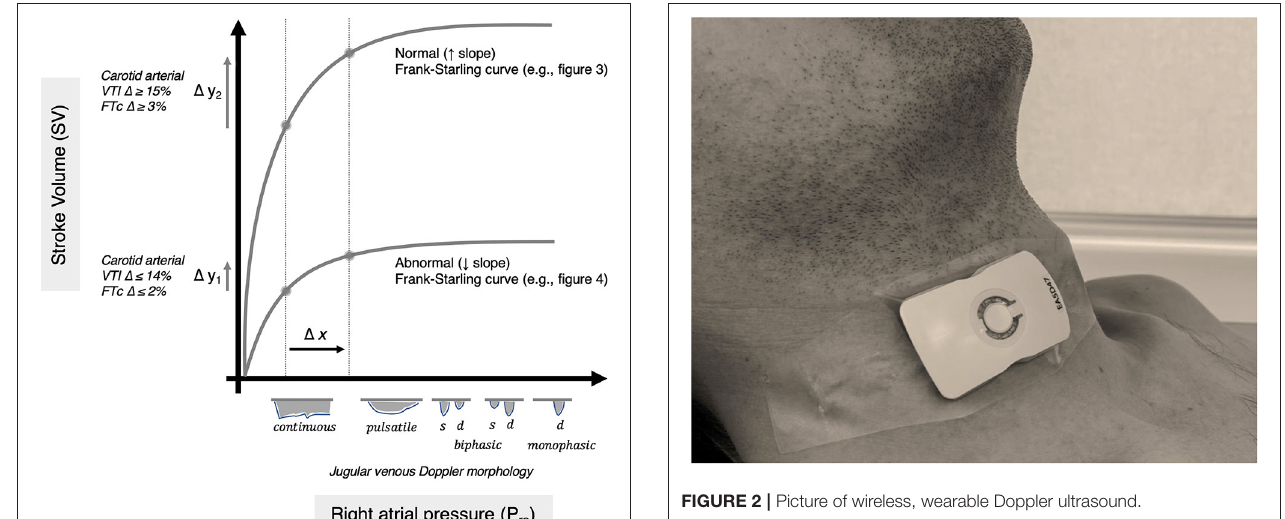
as neck position does not change during the maneuver (34).